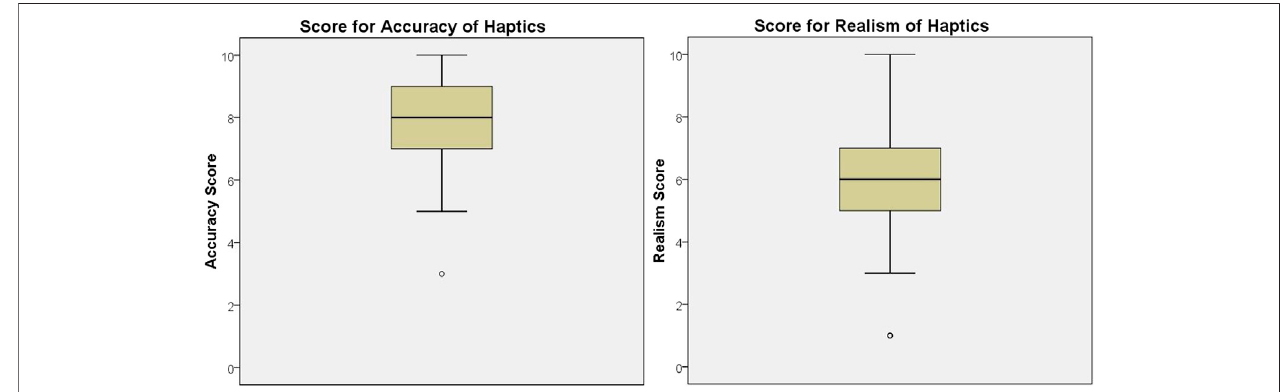
FIGURE 9 | Box and whisker plots showing scores for accuracy and realism of